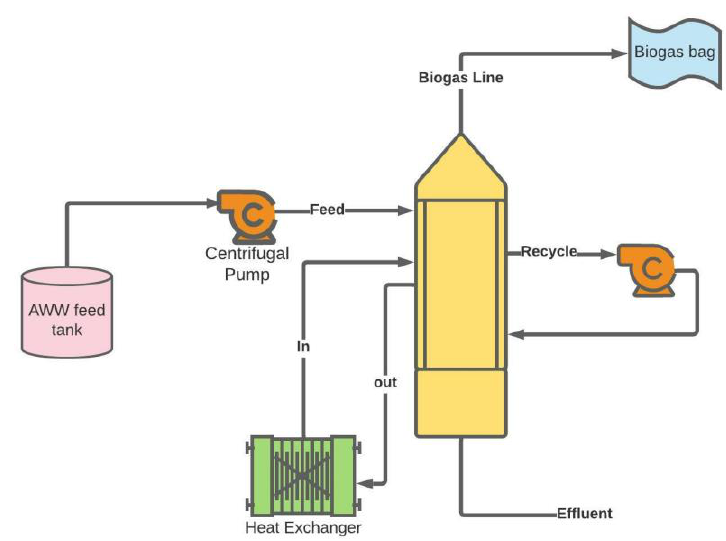
Figure 4. High-rate anaerobic reactor (Downflow Expanded Granular Bed Reactor).